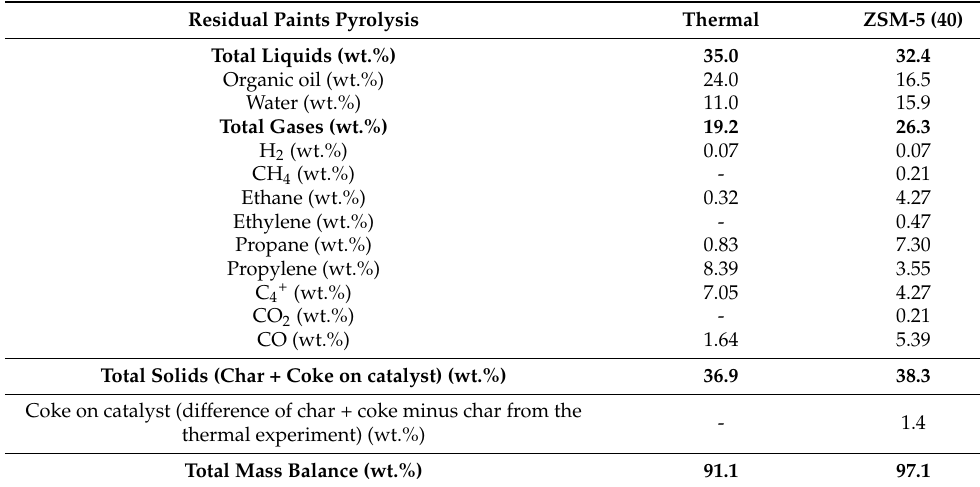
Table 5. Product yields in thermal and catalytic fast pyrolysis of residual paints, at 600 ◦ C, obtained on fixed-bed reactor (C/F mass ratio = 1). Residual Paints Pyrolysis